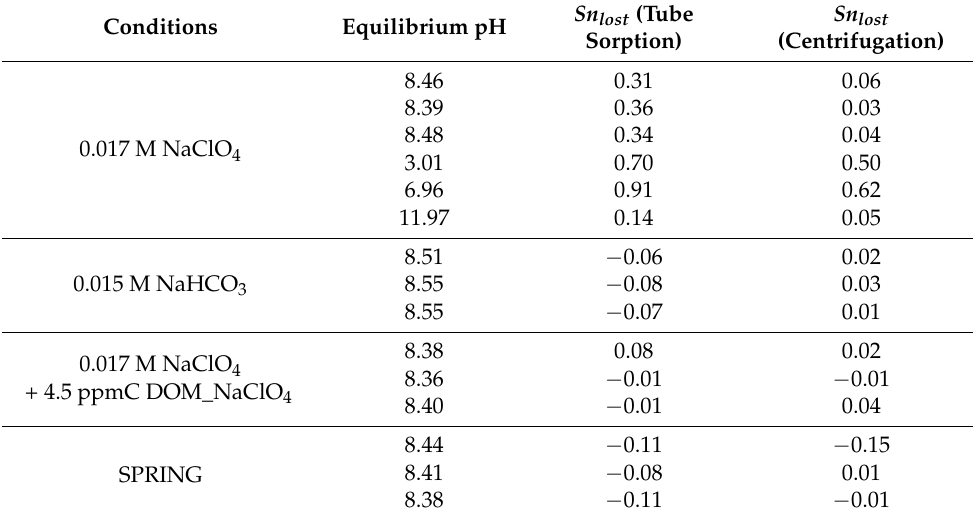
Table A1. Fraction of Sn(IV) lost in the blank solutions during the contact time or during the centrifugation